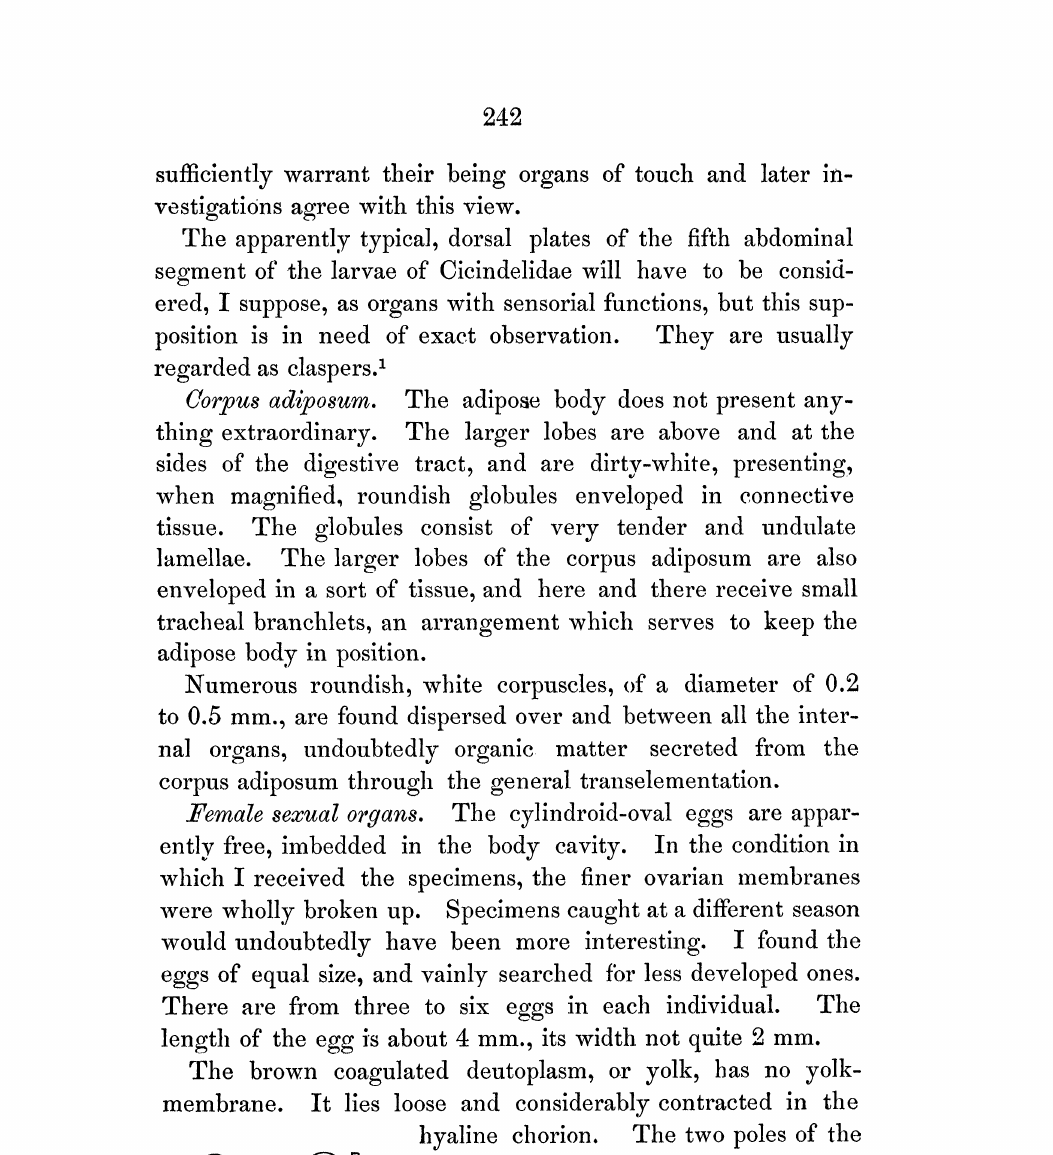
globules, irregularly dispersed, having Horn;